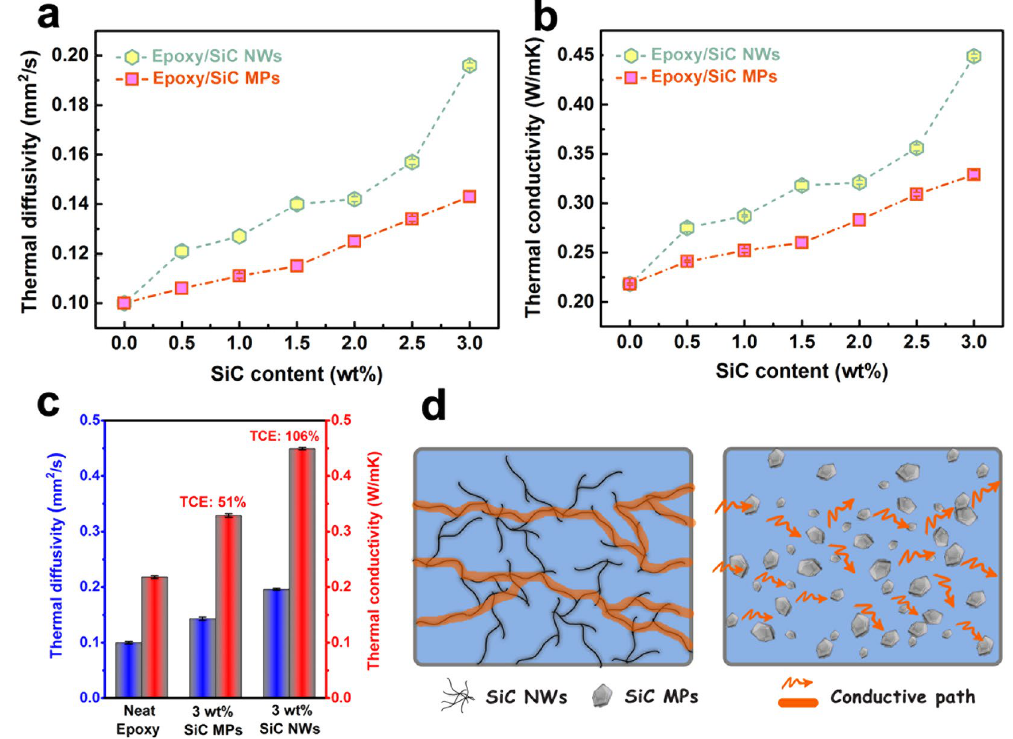
Figure 5. ( a ) Thermal diffusivity and ( b ) thermal conductivity as a function of SiC NWs or SiC MPs content; ( c ) Thermal conductivity enhancement (TCE) of epoxy composites with 3 wt% filler compared to neat epoxy; ( d ) The model of heat flow for the epoxy